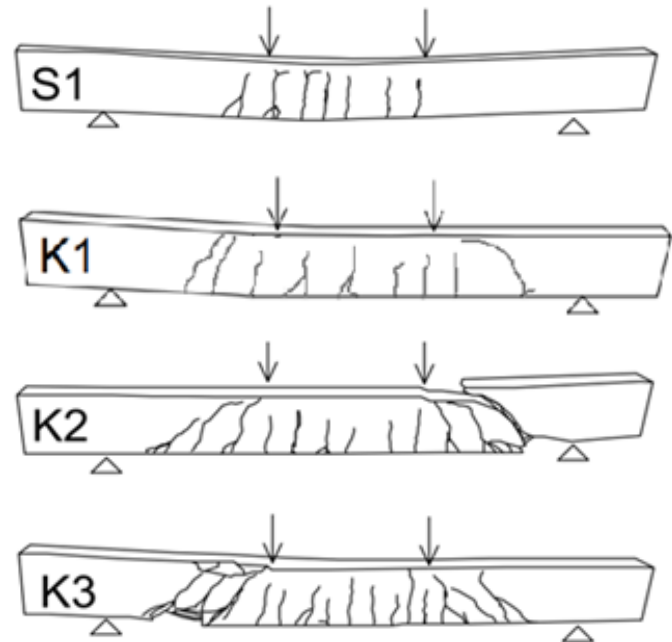
Figure 5. Development of cracks in studied beams at failure.